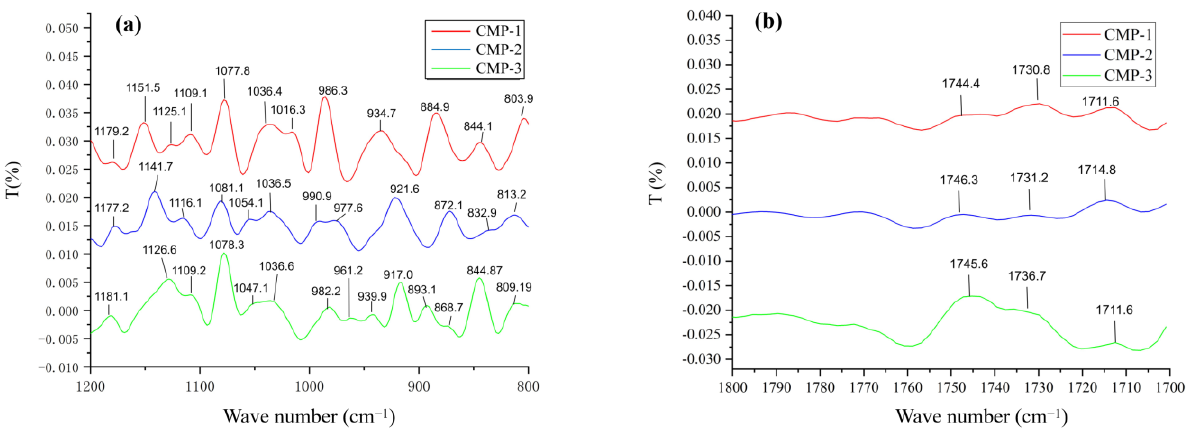
Figure 6. The second derivative FT-IR spectrum of three polysaccharides in the range of 800~1200 cm − 1 ( a ) and 1700 ~ 1800 cm − 1 ( b ).